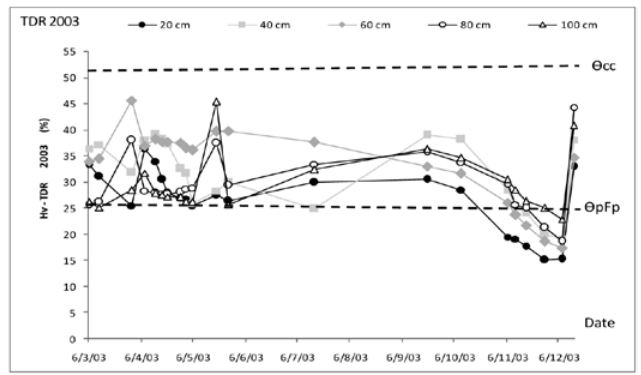
Fig. 5 - Evolution of the TDR-soil water content measurements accord- ing to depth in 2003.